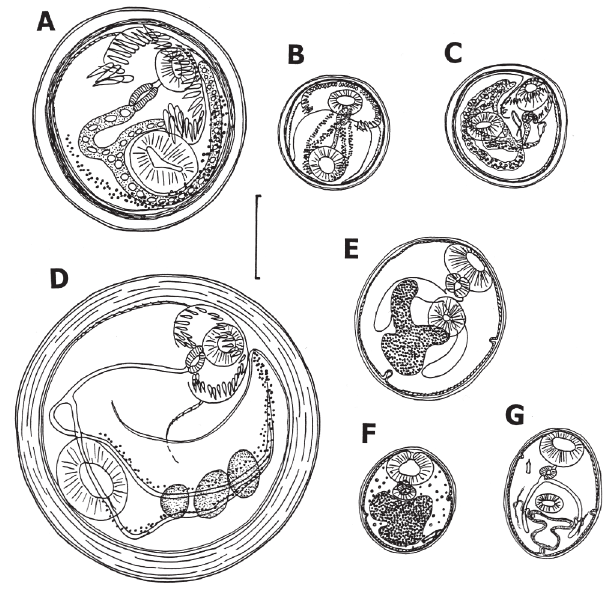
Fig. 6. – Echinoparyphium aconiatum (A), Echinoparyphium recur- vatum (B), Echinostoma sp. (C), Moliniella anceps (D), Opisthio- glyphe ranae (E), Plagiorchis sp. (F), Neoglyphe locellus (G); scale bar 100